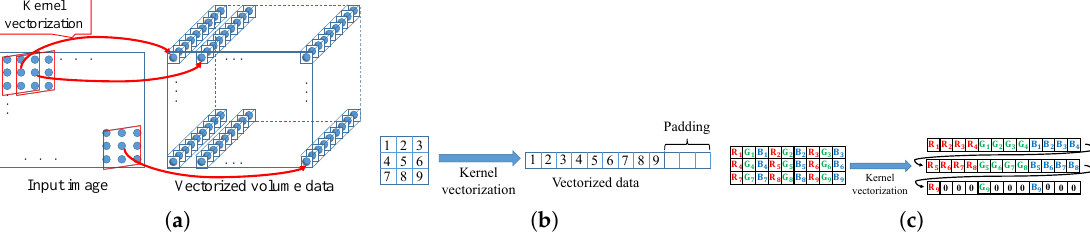
Figure 6. Kernel vectorization. ( a ) Rearrange approach; ( b ) Data structure of a pixel in gray image; ( c ) Data structure of a pixel in color image. The size of the SIMD register is 4.